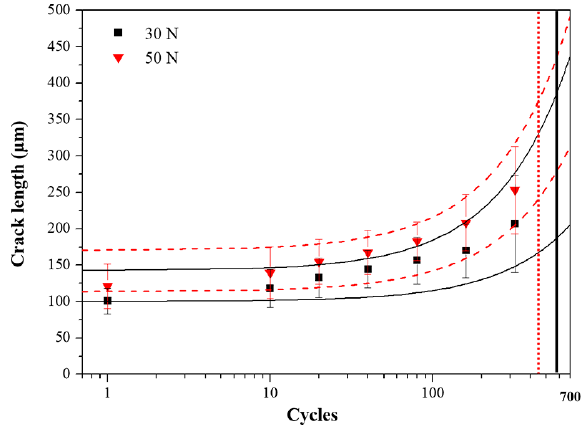
Figure 7. Variation of crack length on the surface during CTF tests. Dotted and solid curves indicate empirical data fits for 30 and 50 N, respectively. Dotted and solid vertical lines are the failure cycles of TBCs with cracks formed by 30 and 50 N, respectively.